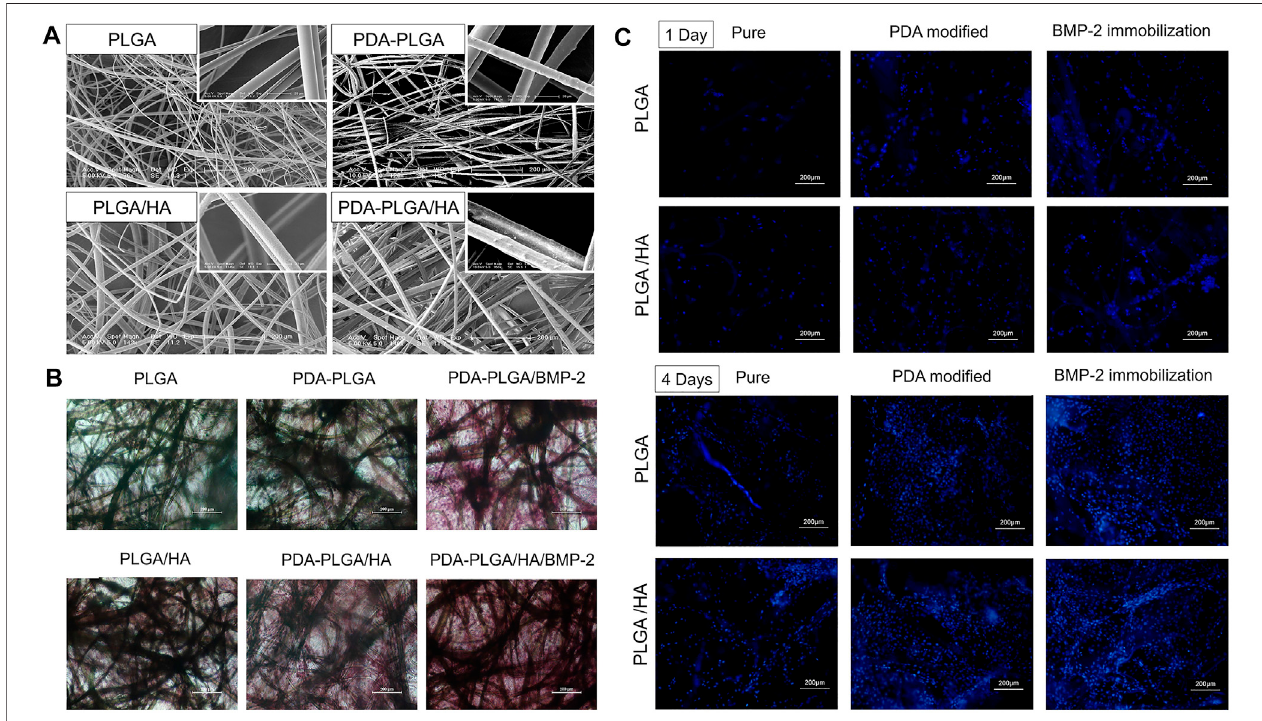
FIGURE 7 | (A) SEM micro-photographs of PLGA, PDA-PLGA, PLGA/HA, and PDA-PLGA/HA scaffolds. (B) Alizarin Red staining of MC3T3-E1 cells cultured on PLGA, PLGA/HA, PDA-PLGA, PDA-PLGA/HA, PDA-PLGA/BMP-2, PDA-PLGA/HA/BMP-2 on day 21. (C) Fluorescence staining of MC3T3-E1 cells cultured on the different scaffolds for 1 – 4 days. Reprinted with permission from (Zhao X. et al.,